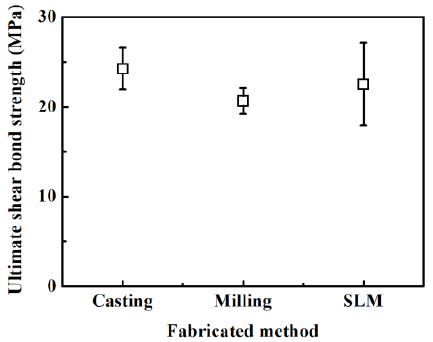
Figure 4. Shear bond strength values following different manufacturing techniques.